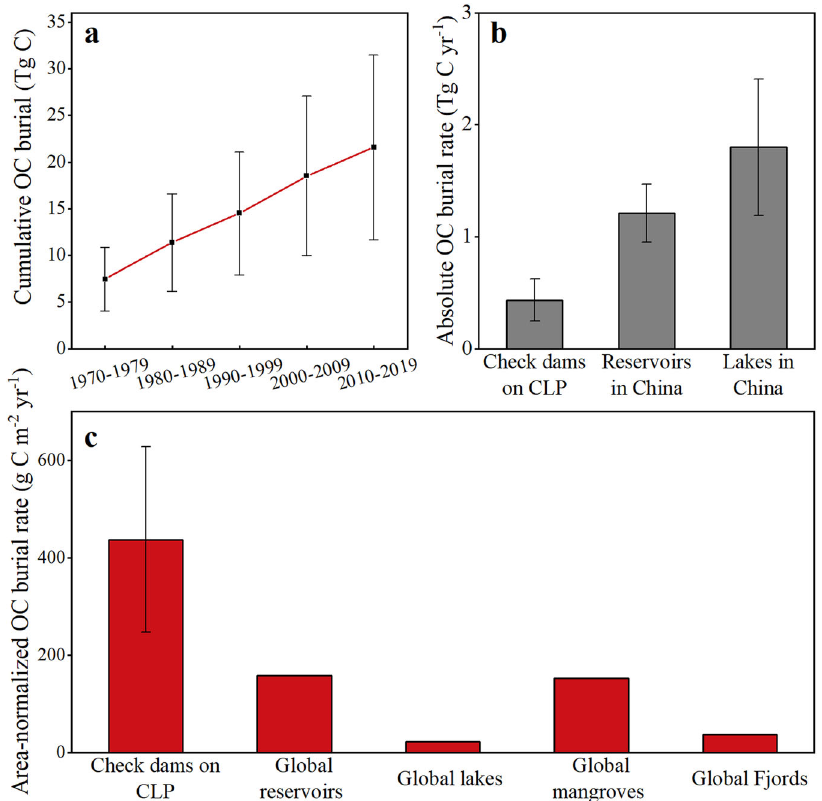
Fig. 6 Organic carbon (OC) buried behind check dams. a Cumulative buried OC of check dams on the Chinese Loess Plateau at different historical stages. b Absolute OC burial rates in typical terrestrial depositional environments in China. c Area-normalized OC burial rates in different depositional environments. Error bars represent standard deviation. Note: the error range is too large or not provided in the original references, so we do not show the error bar for other terrestrial depositional environments in Fig.